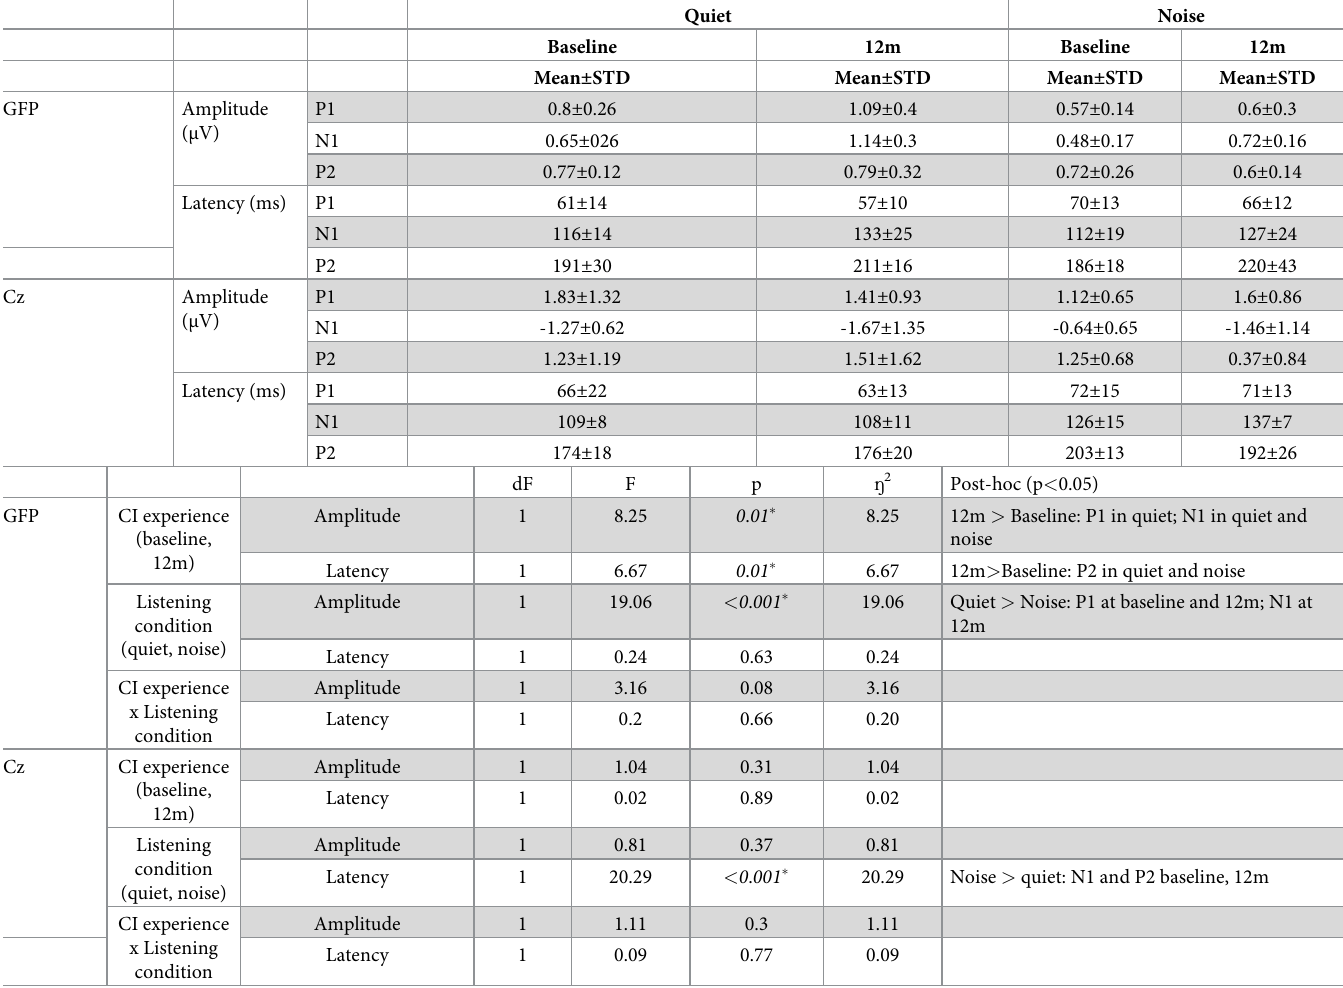
Table 3. Top: Mean CAEP amplitudes and latencies for GFP and at CZ for SSD-CI participants, in quiet and in noise and at baseline and after 12 months of CI experience. Bottom: Results of MANCOVA tests on GFP and Cz responses for CI experience and listening condition (quiet vs. noise).